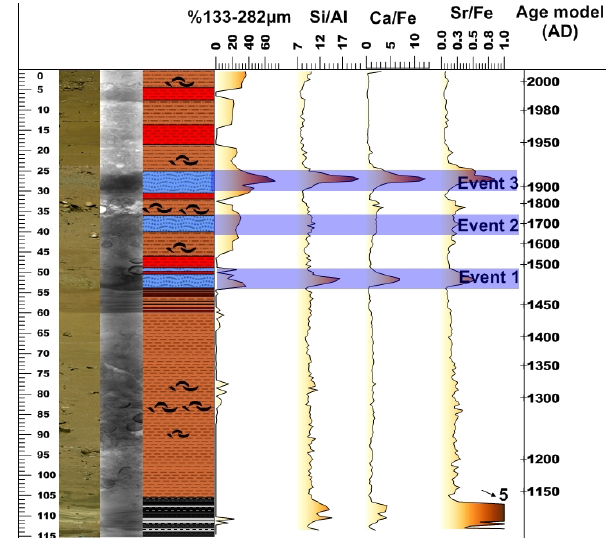
Figure 8. Identification of paleoevents based on photography, radio- graphy X, log, grain size and geochemical inter-element ratios. The identified events show coarse grained texture in photography, dark layer in radiography X, high percentage of 133–282µm fraction and peaks of Si / Al, Ca / Fe and Sr / Fe